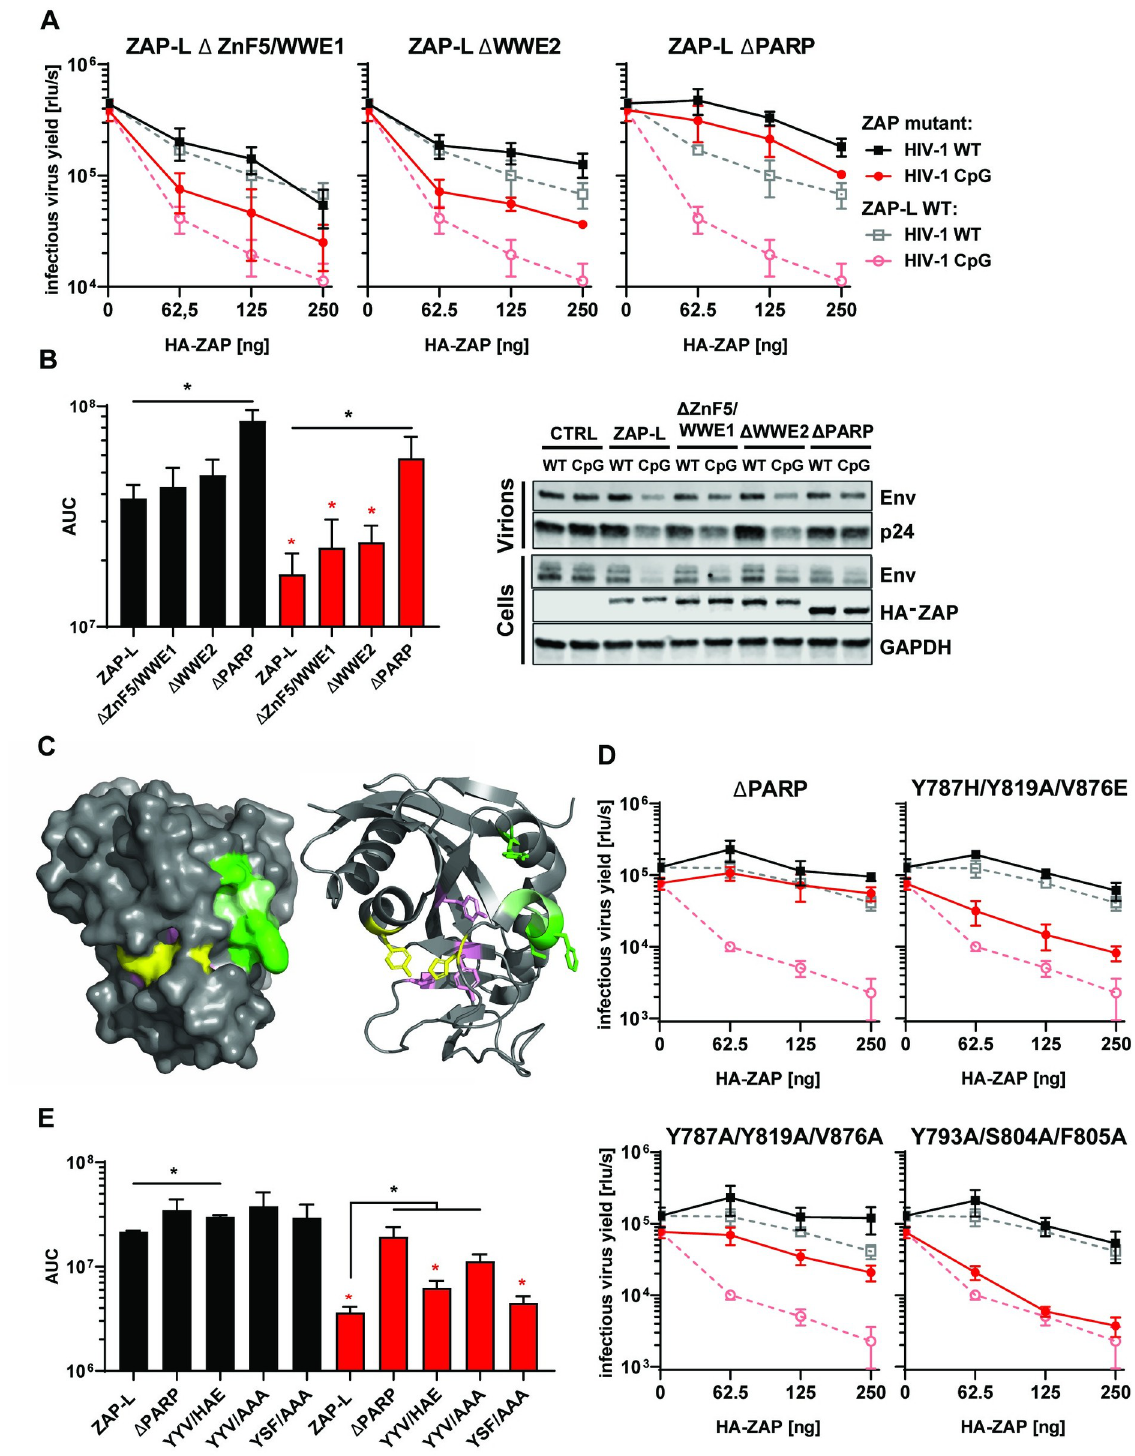
Fig 2. Determinants of ZAP’s function located outside RBD. (A) Infectious virus yield from HEK293T ZAP KO co-transfected with WT (black) and mutant (red) virus and increasing concentration of pcDNA HA-ZAP-L control (dashed line) or mutated pcDNA HA-ZAP with deleted ZnF5 and first WWE domain ( Δ 511–563; Δ ZnF5/WWE1), second WWE ( Δ 594–681; Δ WWE2) or PARP domain ( Δ 716–902; Δ PARP). (B) Corresponding AUC values and representative western blot (250ng). (C) Position of studied residues in crystal structure of ZAP’s PARP domain. Residues under positive selection in primates are shown in green, canonical triad positions in pink and residues